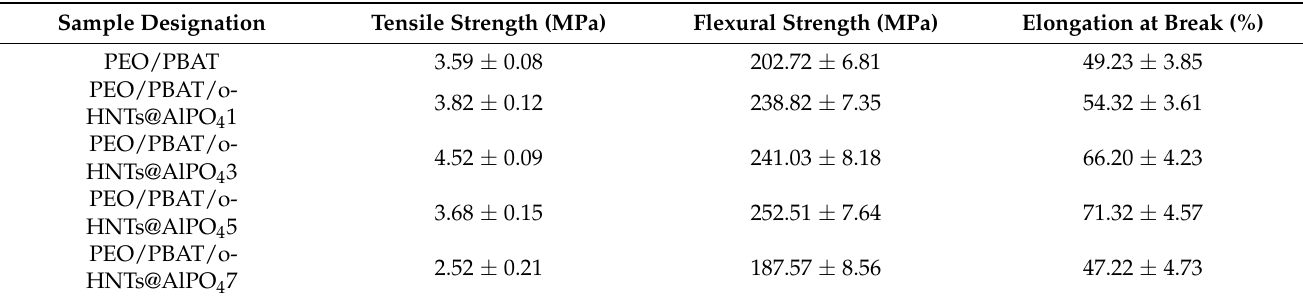
Table 4. The mechanical properties of the PEO/PBAT/o-HNTs@AlPO 4